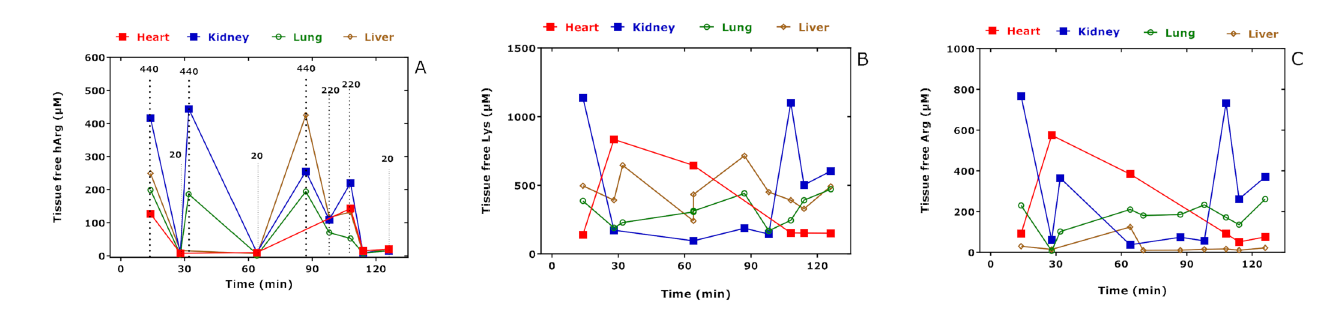
Figure 1. Tissue-free hArg ( A ), Lys ( B ), and Arg ( C ) concentrations in the study rats administered with the indicated hArg doses at t = 0 min and sacrificed at the indicated time points. See also Table